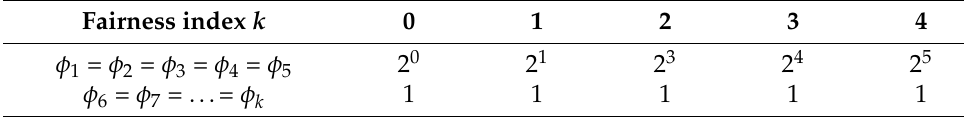
Table 1. Fairness Rate